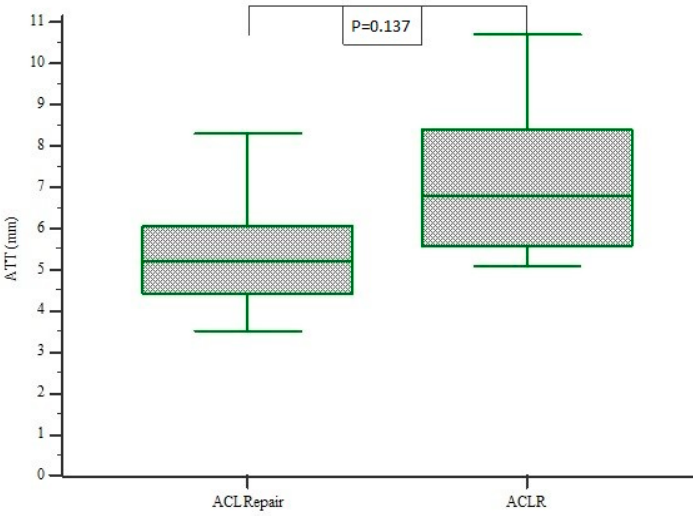
Figure 4. Box plot of assessments of anterior tibial translation (ATT) comparing the difference between ACL repair and ACLR group. ATT was significantly decreased in the ACL repair group compared with the ACLR group (5.31 mm vs. 7.18 mm, respectively; p = 0.0137). Moreover, GNRB measurements demonstrated a significantly decreased mean side- to-side difference ( ∆ ATT) at 1.87 (range 0.2 to 4.9) mm when compared to ACLR at 3.36 (range 1.2 to 5.6 mm; p = 0.0107) (Figure 5).